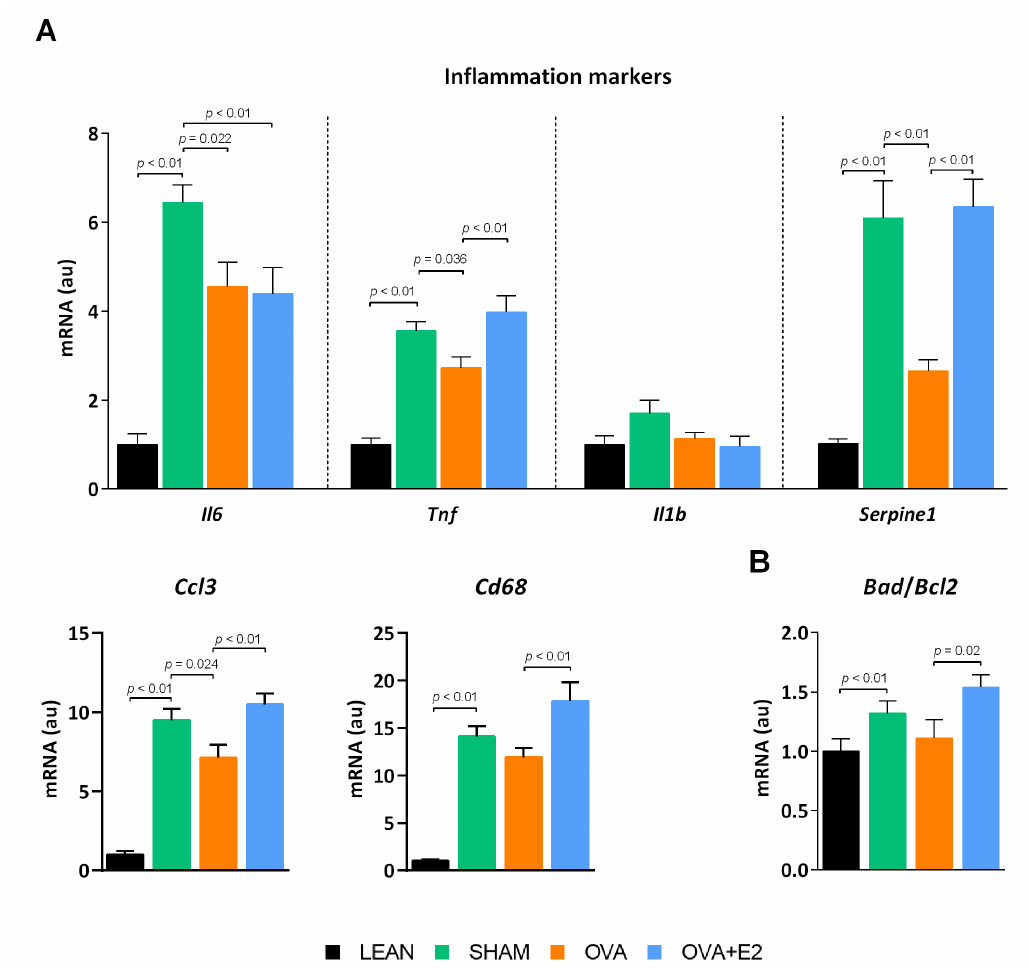
Figure 5. Ovariectomy and E2 treatment effects on ( A ) inflammatory adipokine expression profile and ( B ) markers of apoptosis in WAT of female ZDF rats. Il , interleukin; Tnf , tumor necrosis factor alpha; Serpine1 , plasminogen activator inhibitor-1; Ccl3 , macrophage inflammatory protein-1 alpha; Cd68 , cluster of differentiation 68; Bad , Bcl-2-associated death promoter; Bcl2 , B-cell lymphoma 2. mRNA levels were normalized to housekeeping Gapdh mRNA expression. Values are expressed as the mean ± SEM in arbitrary units (au) related to LEAN group. Differences between obese-diabetic (SHAM) and control (LEAN) animals were analyzed by Student’s t -test. Differences between obese-diabetic groups with different hormonal manipulation were analyzed by One-way ANOVA with Fisher’s LSD post-hoc test .